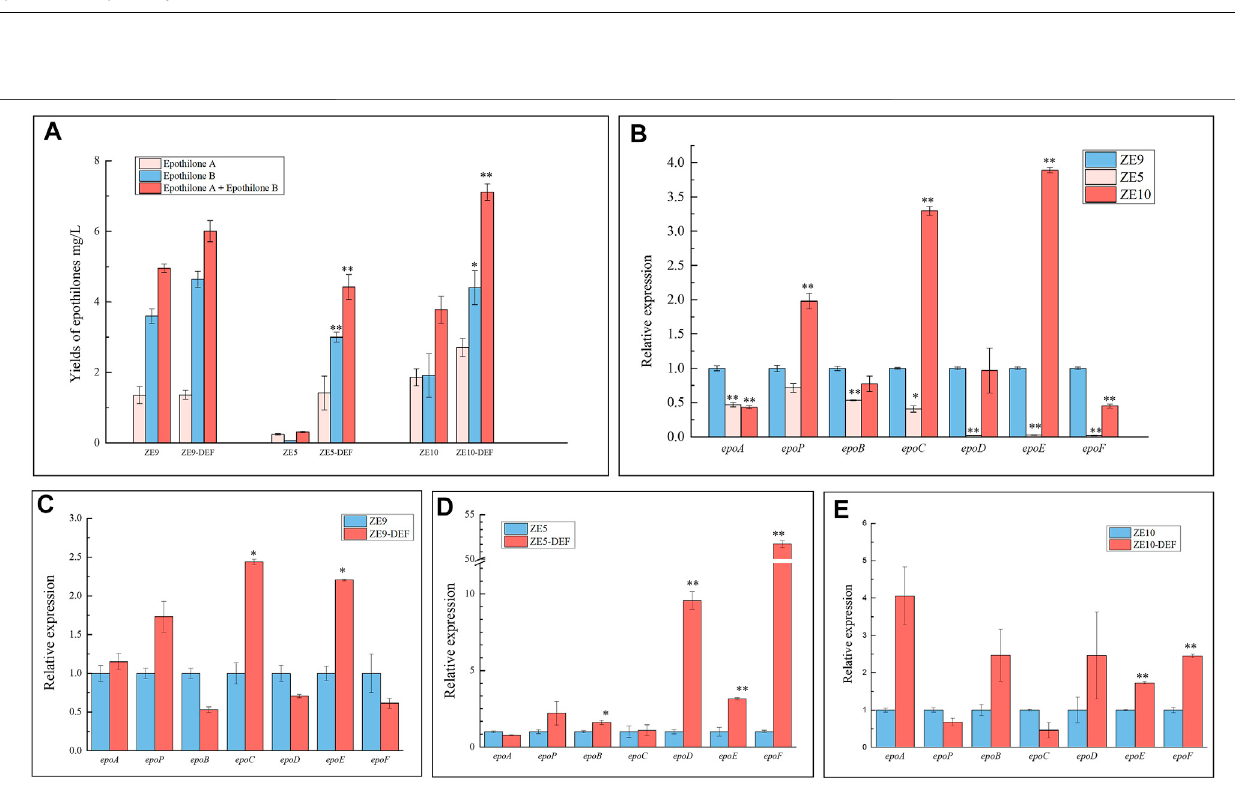
FIGURE5| CRISPRaofinternalpromotersindifferentepothilone-producing M . xanthus strainsZE9,ZE5,andZE10. (A) Yieldofepothilonesinwildstrainsand the activation mutants. (B) RT-qPCR analysis of expression levels of the seven operon genes in ZE9, ZE5, and ZE10 after 48 h of incubation. The expressions of the seven operon genes in M . xanthus ZE9 were each set as 1, and the expressions of the genes in other strains are shown as the relative expression. (C,D) RT-qPCR analysis of expression levels of the seven operon genes in the activation mutants after 48 h of incubation. The expressions of the seven operon genes in wild strains were each set as 1, and the expressions of the genes in mutant strains are shown as the relative expression. The error bars represent the standard deviation of three independent experiments. For statistical analysis between the ancestral strain and mutant strains, the signals of ** and * mean p < 0.01 and p < 0.05,